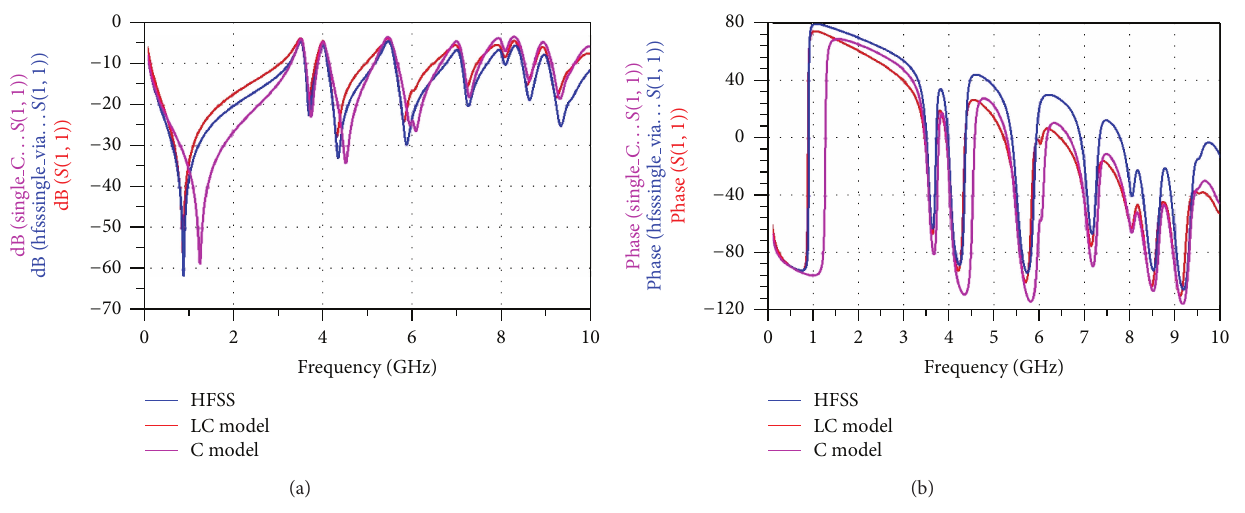
Figure 12: 𝑆 11 of a single via structure: (a) amplitude; (b)